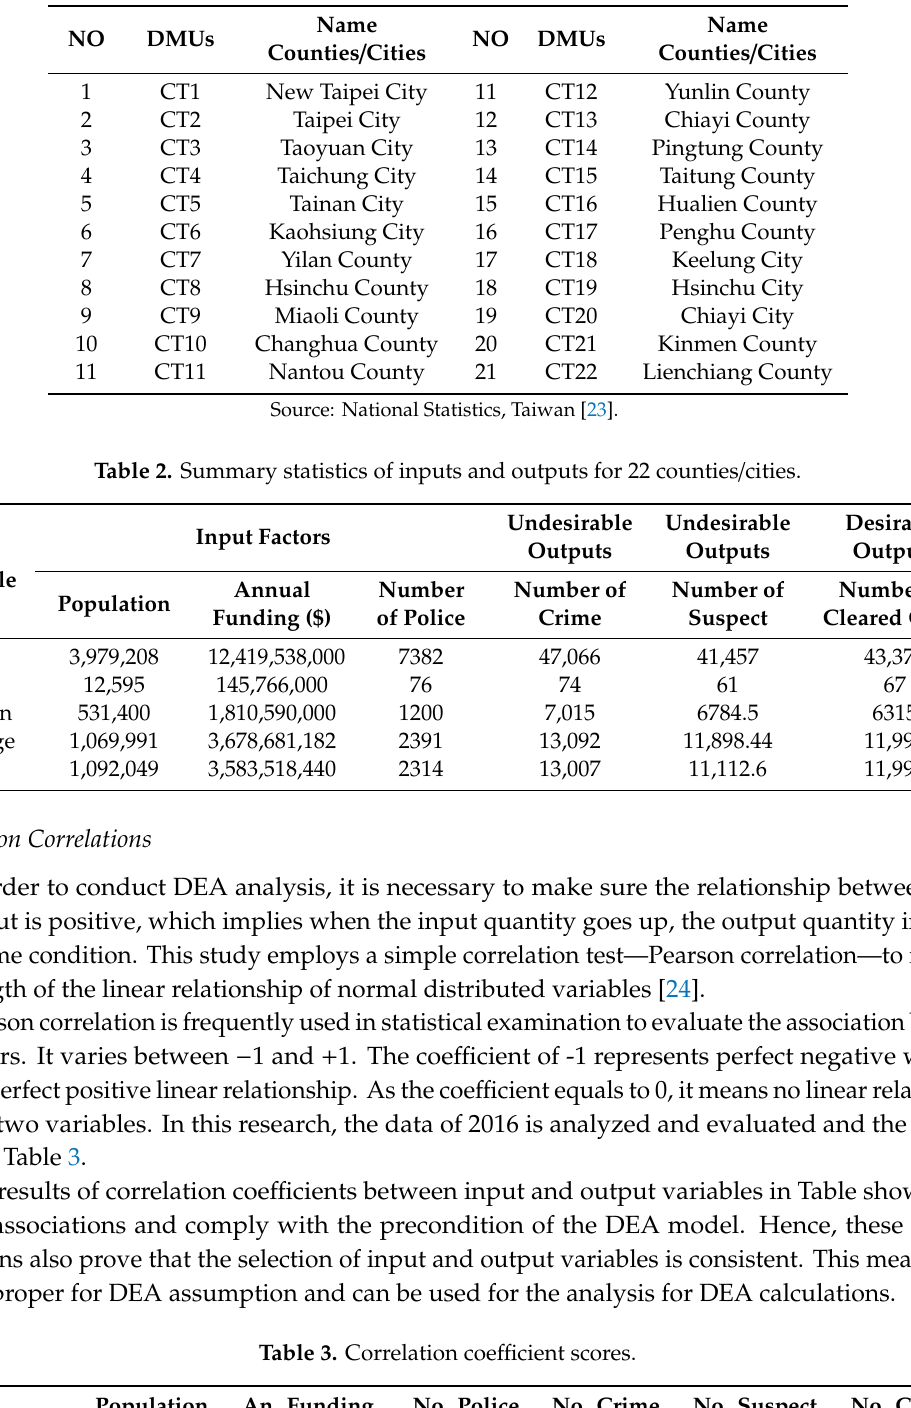
Table 1. Names of counties and cities in Taiwan.